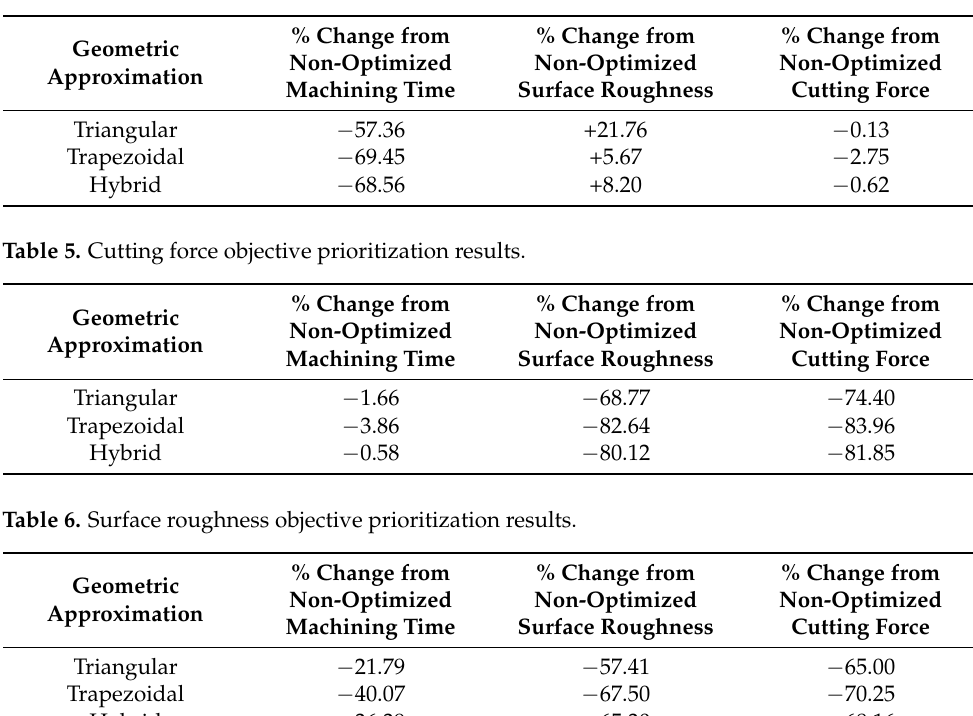
Table 4. Machining time objective prioritization results.